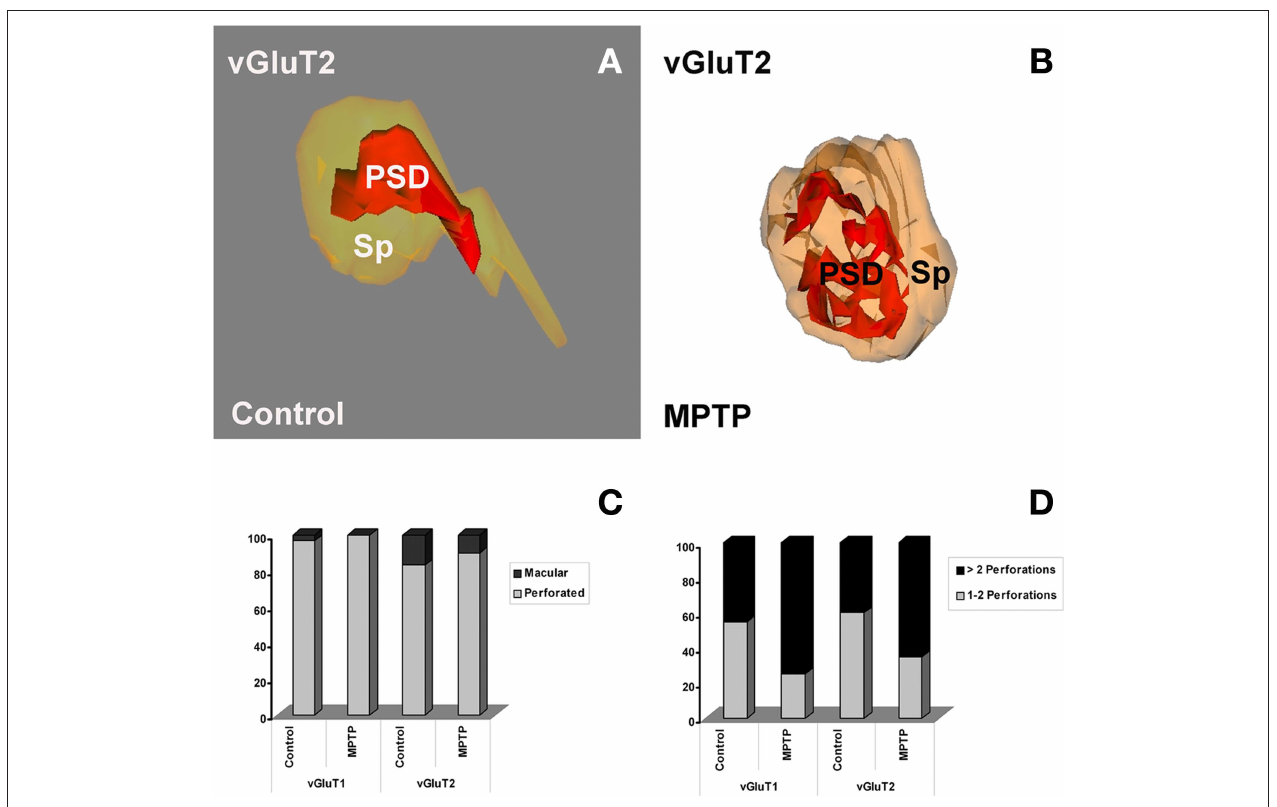
with different number of perforations in spines contacted by vGluT1- or vGluT2-IR terminals in control and MPTP-treated parkinsonian monkeys. The proportion of complex PSDs (more than two perforations) is significantly increased (Pearson Chi-square analysis, χ 2 ) in MPTP-treated animals at both corticostriatal ( χ 2 = 4.78; P = 0.03) and thalamostriatal ( χ 2 = 4.34; P = 0.035) axo-spinous synapses. Sp, spine; PSD, postsynaptic